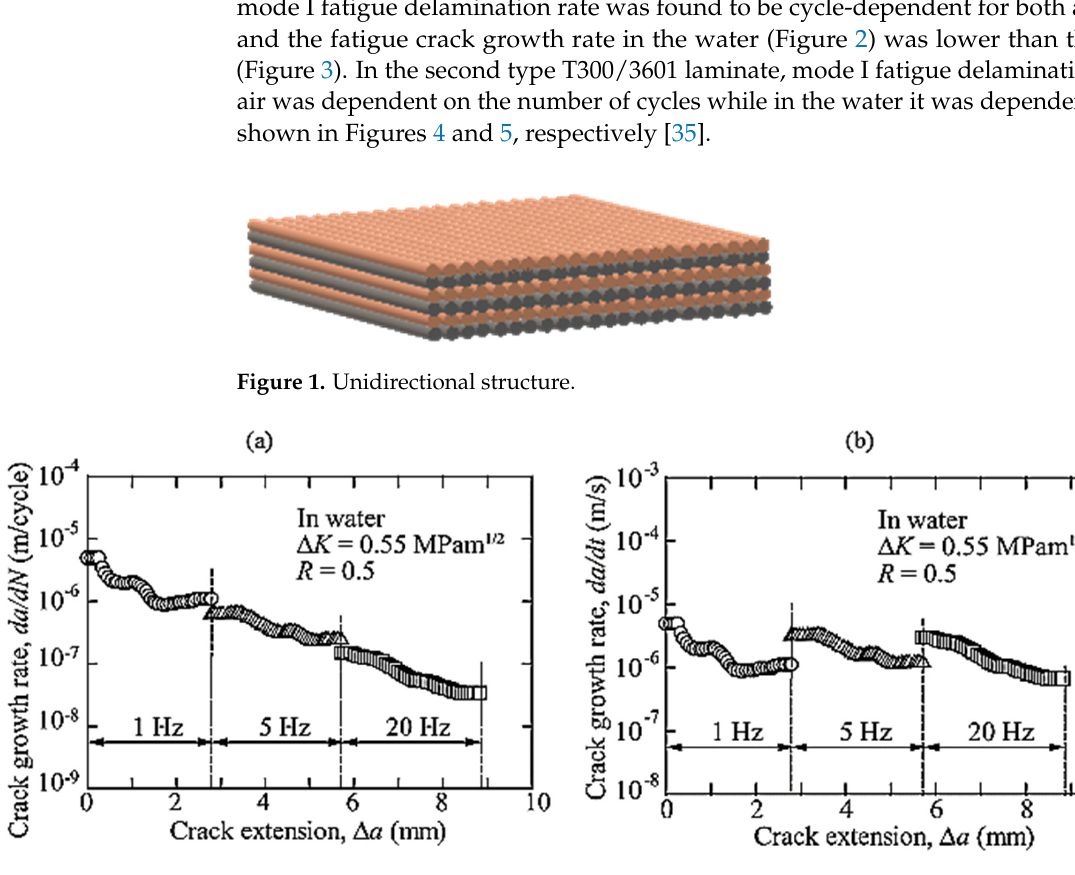
Figure 2. Impact of loading frequency on mode 1 fatigue cracking of M4J/2500 laminates in water ( a ) cycle-dependent cracking rate, ( b ) time-dependent cracking rate [35].